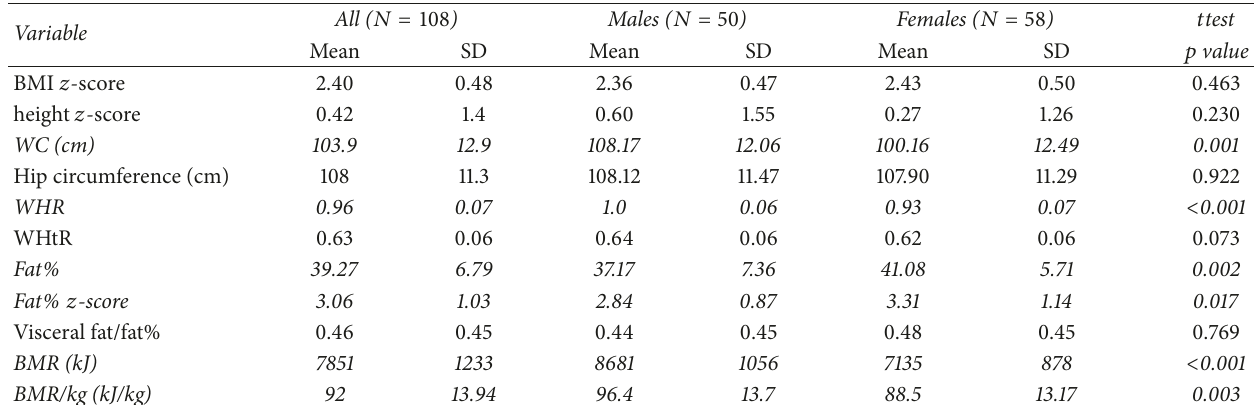
Table 1: Anthropometric characteristic of studied population.